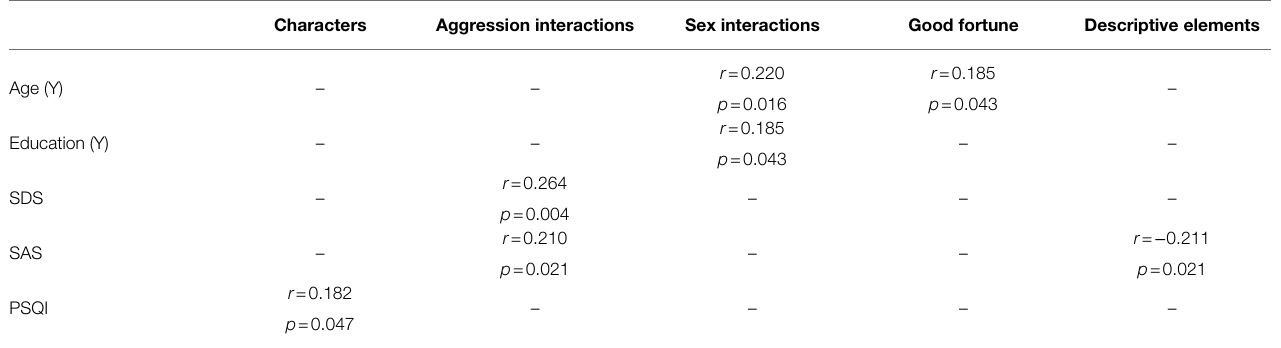
TABLE 2 | Correlations between demographic characteristics, anxiety and depression levels, and sleep qualities and characters, aggression interactions, sex interactions, good fortune, and descriptive elements in the dream content. Characters